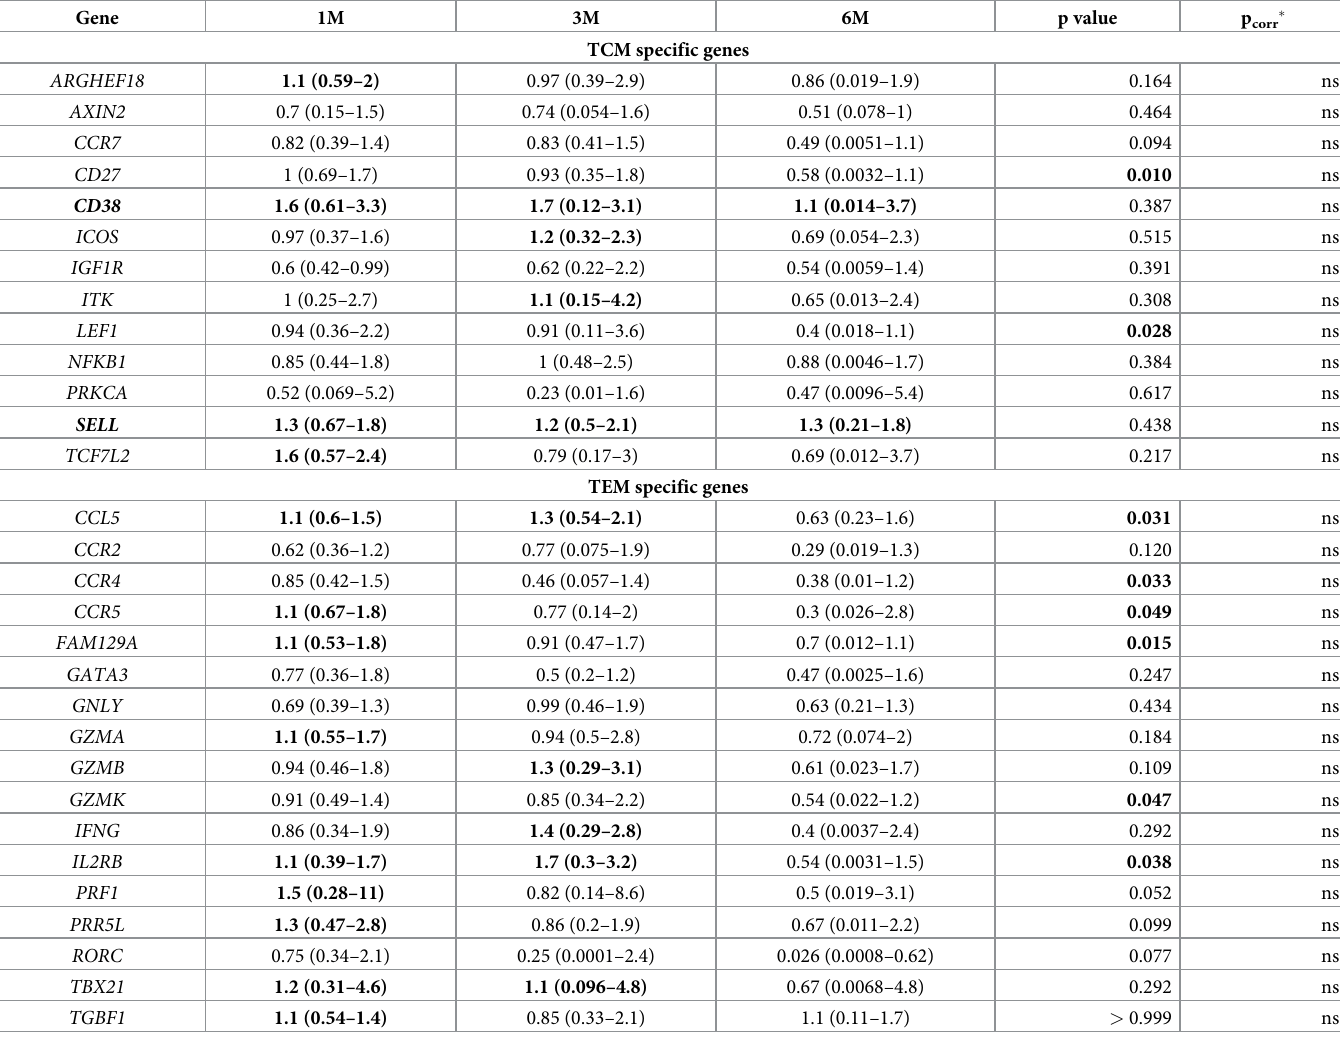
Table 2. Fold change (median and IQR) of gene expression between day 0 and 1M, 3M, 6M of ART, without correction for CD4 counts. Increased gene expression is indicated by values > 1. p-values listed compare gene expression between day 0 and 6 months of ART, as well as after Bonferroni correction for multiple comparisons (p corr �